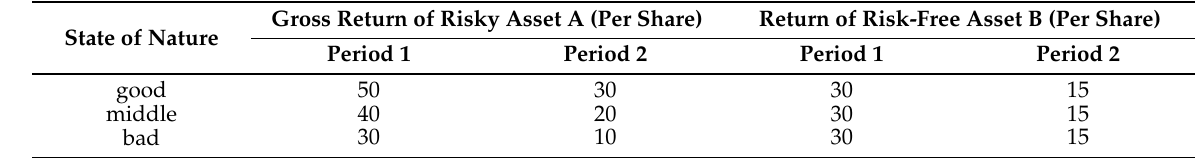
Table 2. Numerical example of possible states of nature.